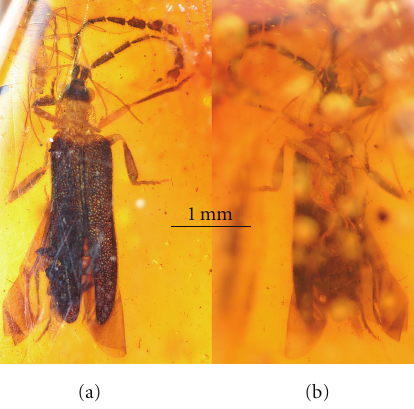
Figure 1: General view of Electropteron avus gen.n. , sp.n. , holotype male: (a) dorsally; (b) same, ventrally.